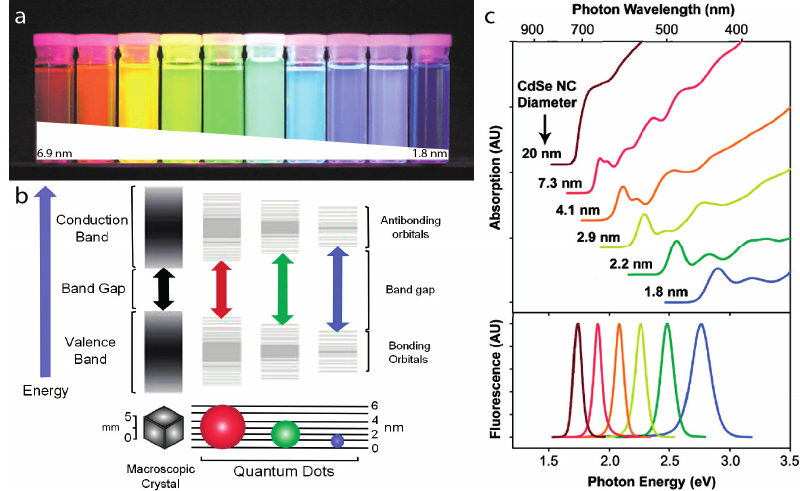
Figure 1. ( a ) CdSe/ZnS core/shell QDs with CdSe core diameters ranging from 6.9 nm to 1.8 nm in diameter emitting with peaks from 1.9–2.8 eV (655–443 nm) from left to right under UV illumination. Adapted with permission from [20]; ( b ) Bandgap energy increases as the nanocrystal size decreases. Reprinted with permission from [38]; ( c ) Absorption (top) and emission (bottom) spectra of CdSe quantum dots. Reprinted with permission from